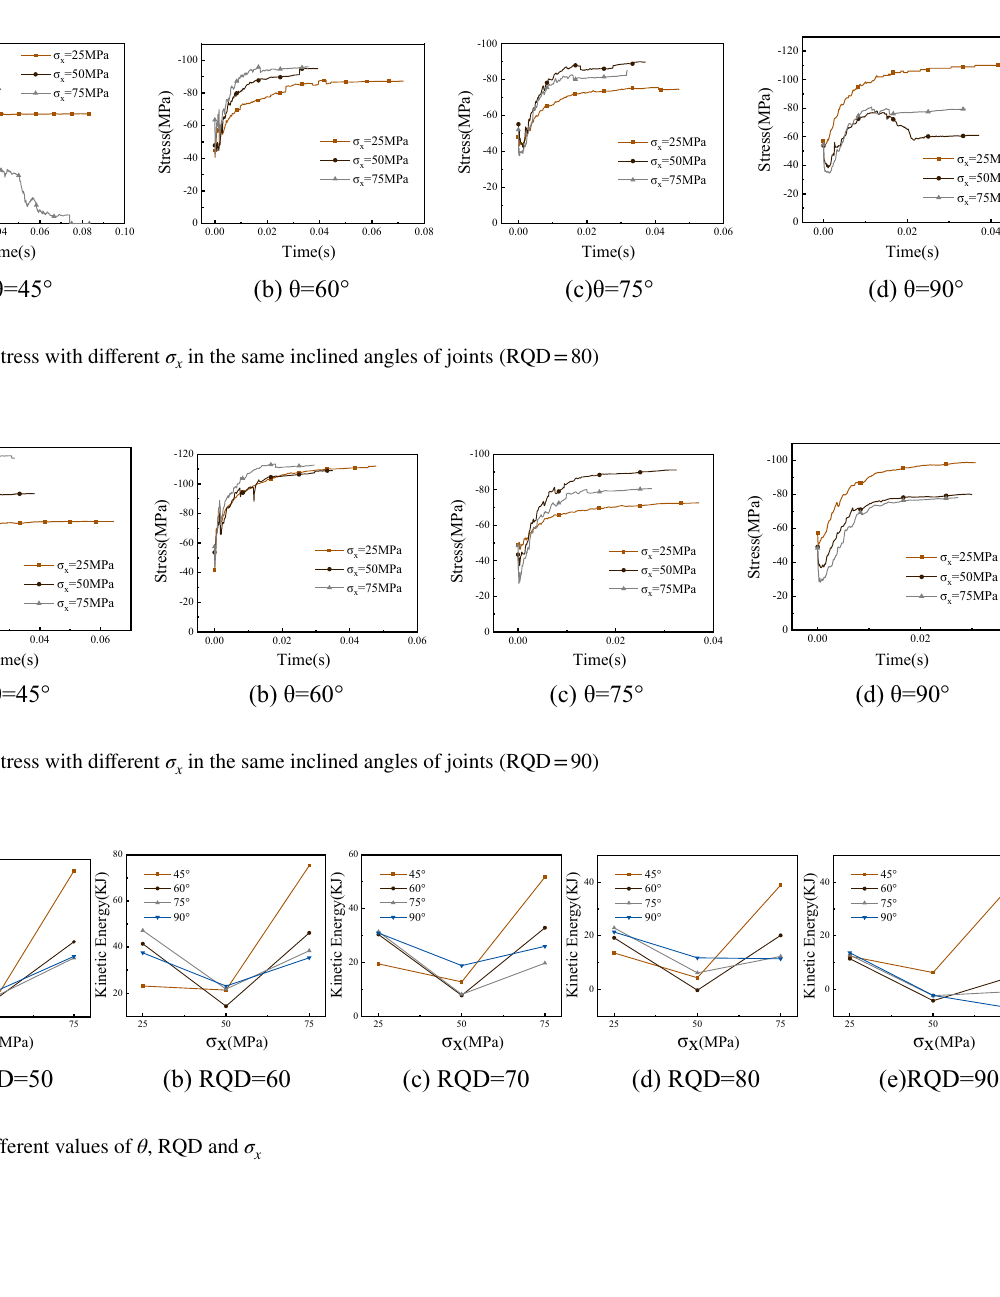
Fig. 26 Tangential stress with different σ x in the same inclined angles of joints (RQD = 70)